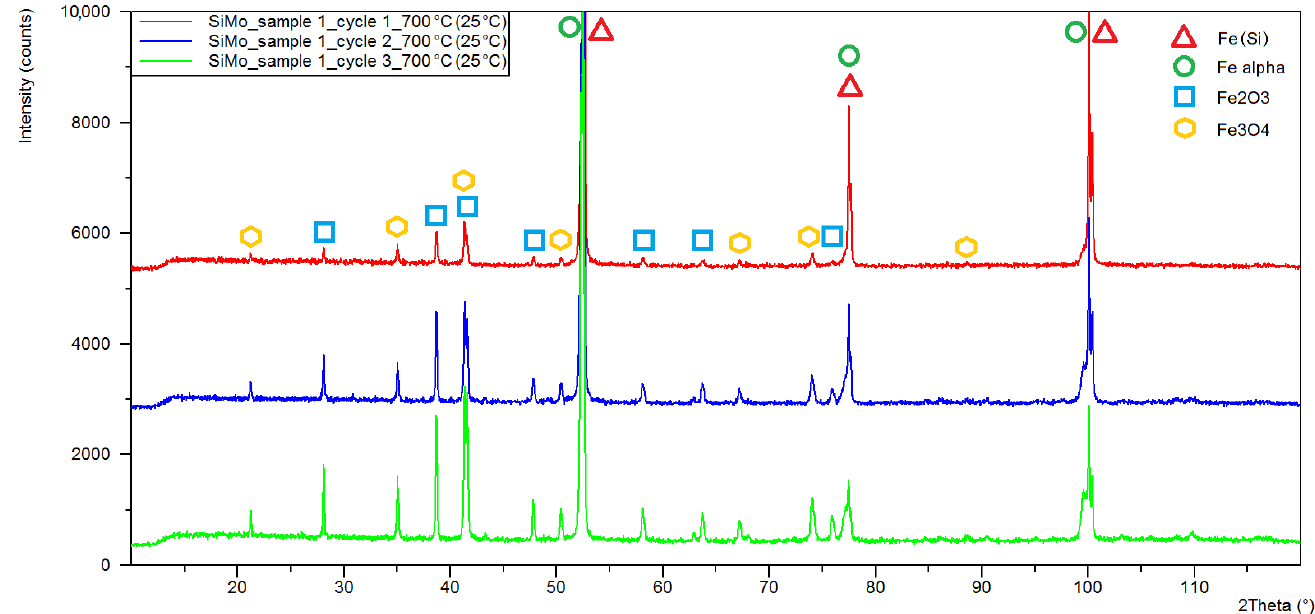
Figure 6. XRD patterns obtained for sample 1 of SiMo cast iron after one (red line), two (blue line) and three (green line) heating cycles at 700 °C.